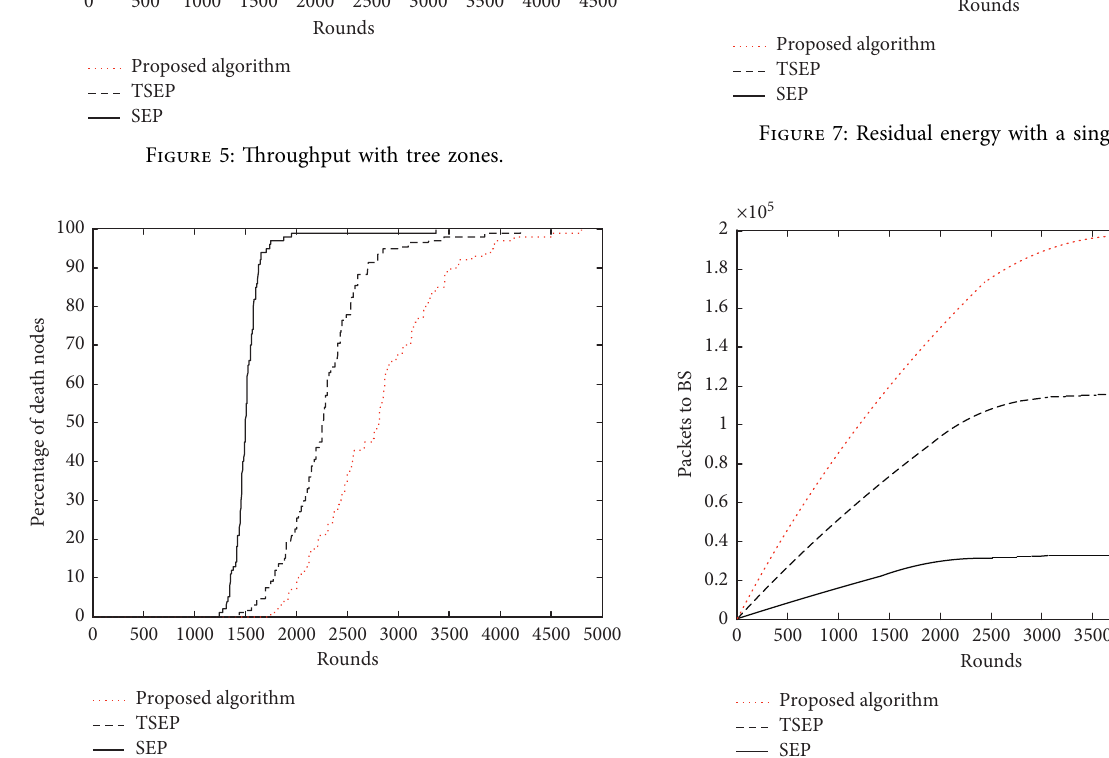
Figure 6: The percentage of death nodes with a single zone.